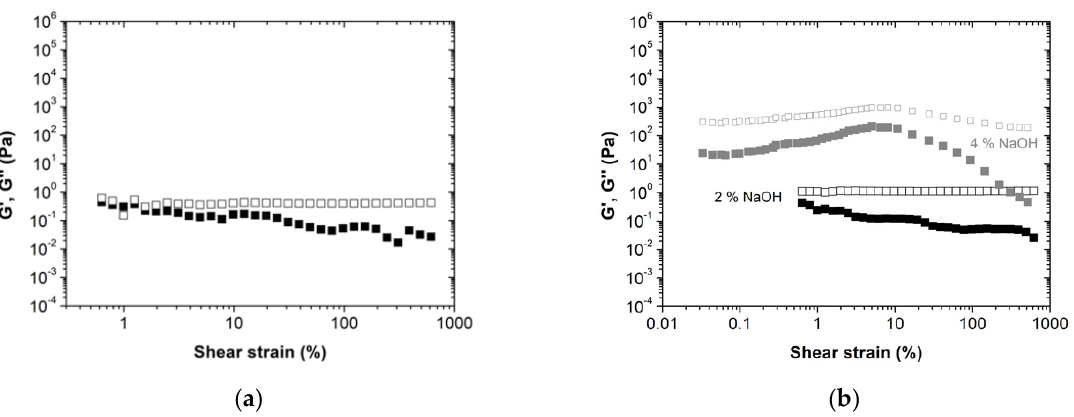
Figure 2. Strain amplitude sweep tests of resole resins: ( a ) without lignin; ( b ) with 50 wt% lignin-LA (right), at 1 Hz and 20 °C. The storage modulus, G’, is represented by full squares, while the loss modulus, G’’, is represented by the empty squares. The different colors of the symbols indicate the different NaOH concentrations: 2 wt%—black, 4 wt%—gray.